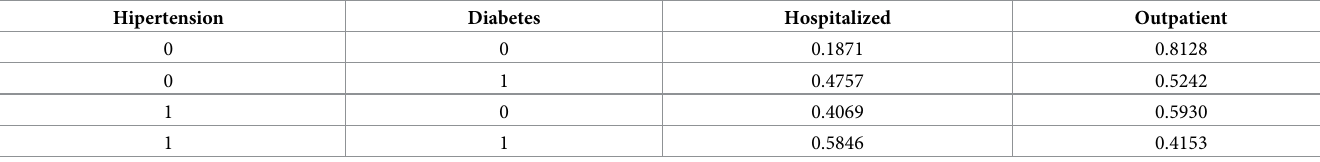
Table 3. Contingency table of patient outpatient versus